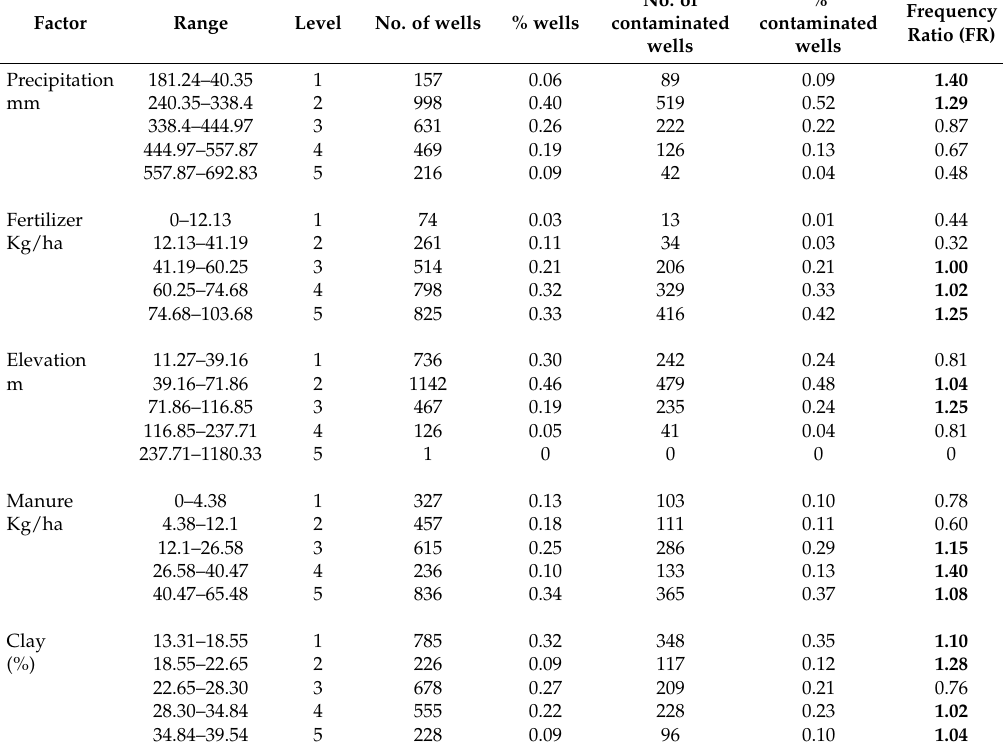
Figure 16. Percent clay in Central Valley. Table 6. Frequency ratio method of significant explanatory